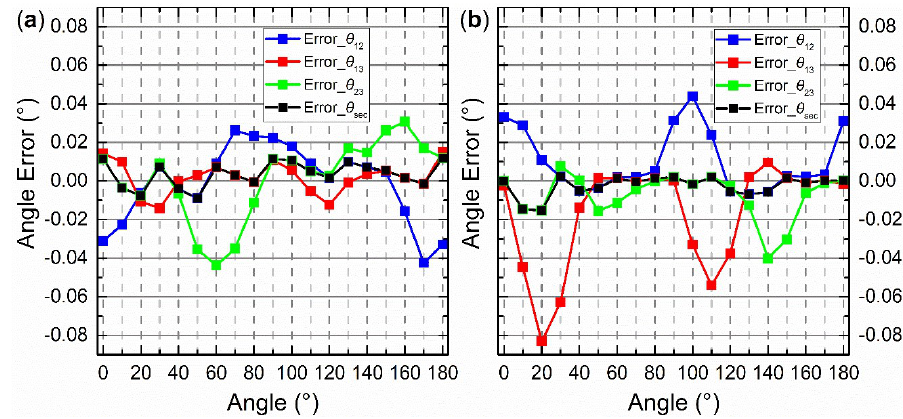
Figure 19. ( a ) Error curves when the central-symmetry method is also used; ( b ) error curves when the noncontinuous method is added.